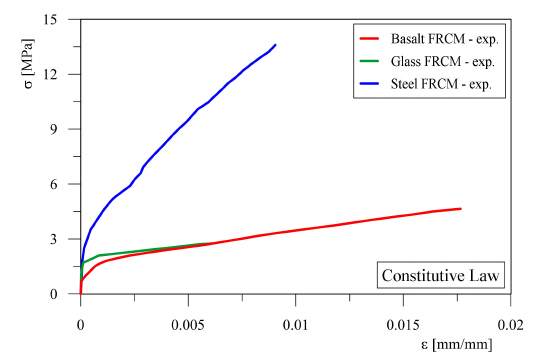
Figure 2. Fiber Reinforced Cementitious Matrix (FRCM) Constitutive Law adopted in finite element (FE) model in Lignola et al., 2019